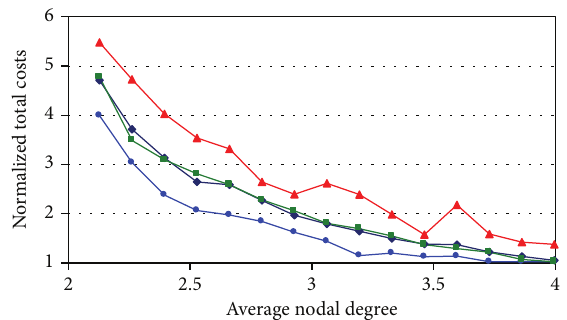
Figure 5: Normalized SBPP JCA total capacity